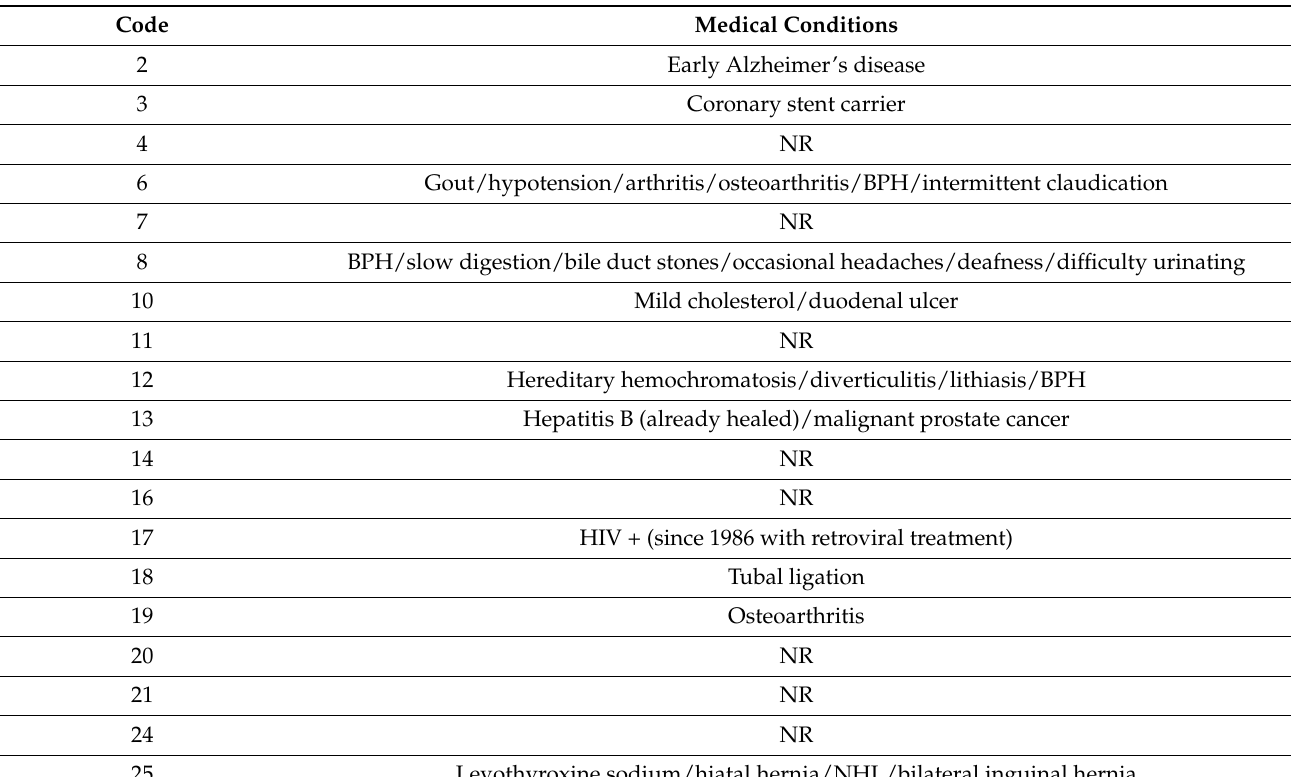
Table 1. Medical conditions of the control